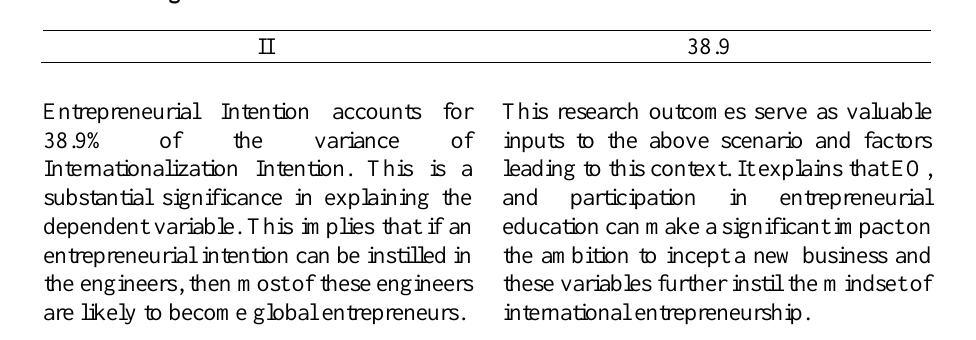
Table 09: Summary of coefficient of determination values for the structural model Endogenous Latent